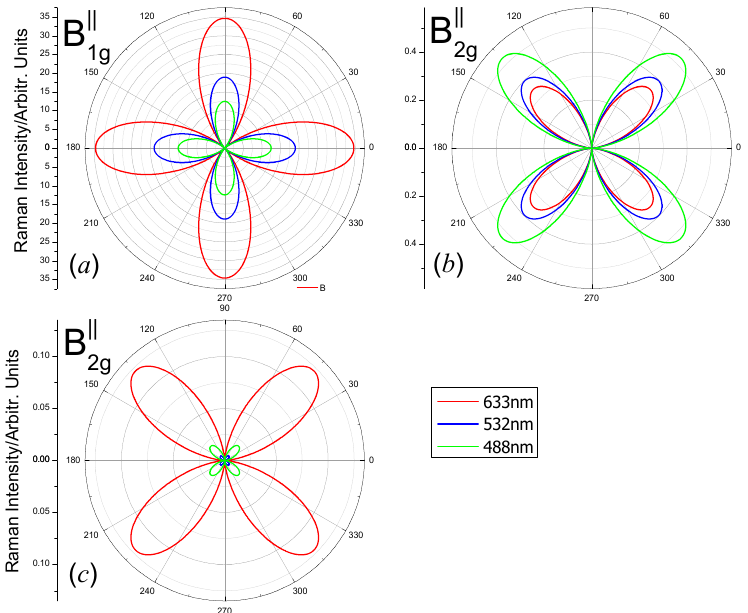
(cid:2870) ↔ 2 of the ( a ) B 1g ‐ 1112 (cid:42) (cid:42) e s · R · e i | of the ( a ) B 1g -1112 cm − 1 , (cid:2870) of the ( a ) B 1g ‐ 1112